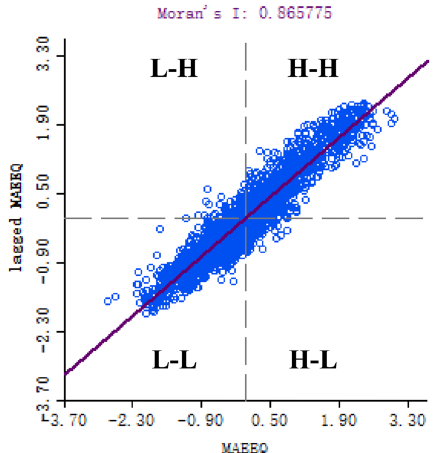
Figure 7. Moran scatter diagram of mining area eco-environmental quality (MAEEQ).